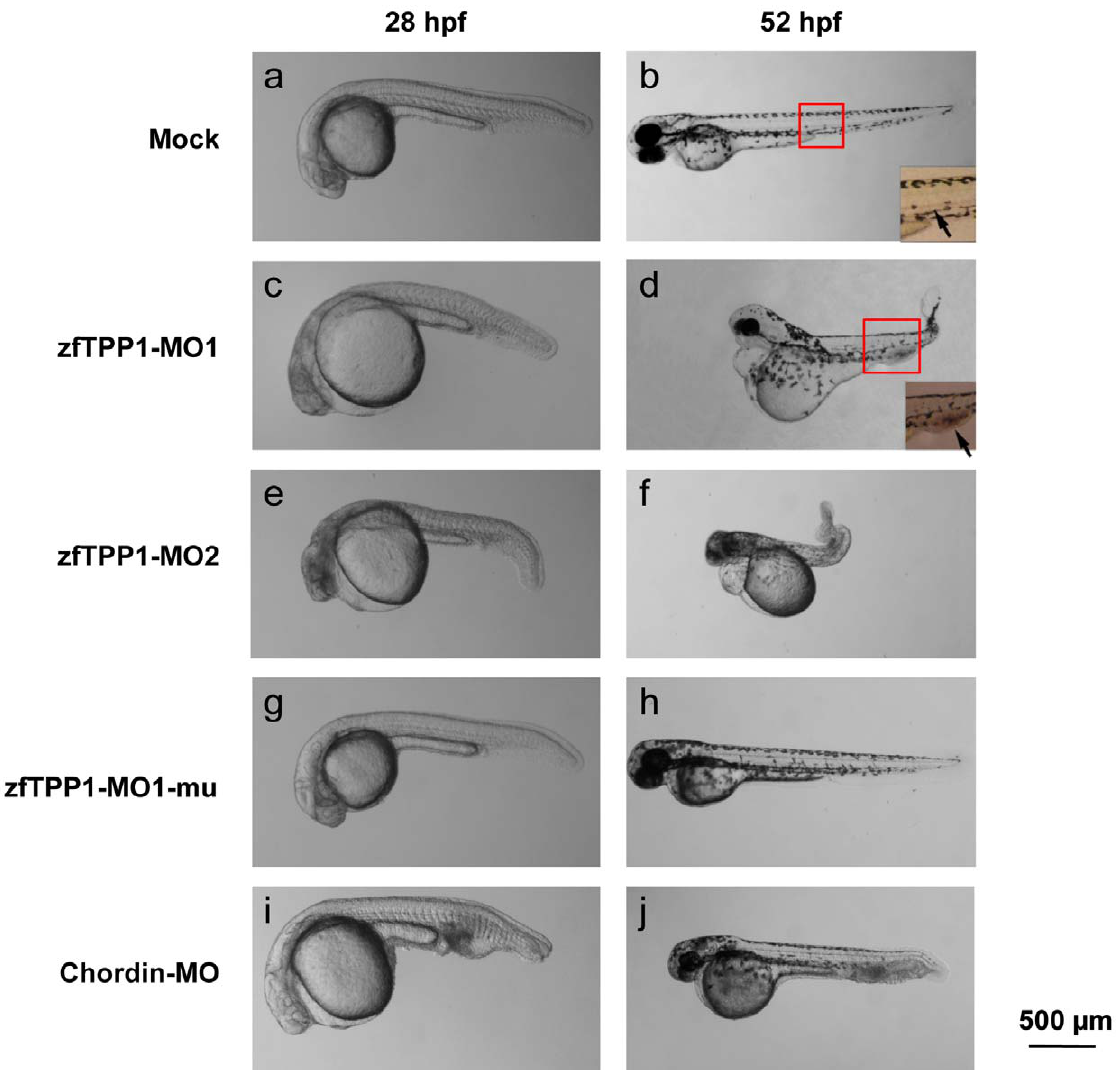
Figure 5. Expression of zfTPP1 morpholinos leads to defects in embryonic development. Mock injected zebrafish embryos (a, b) and those injected with zfTPP1 MO1 (6 ng) (c, d) and MO2 (3 ng) (e, f), zfTPP1 MO1 mutant (6 ng) (g, h), or Chordin MO (6 ng) (i, j), were observed under the microscope at 28 and 52 hour post fertilization (hpf). Magnified images of the trunk region of mock and MO1 injected embryos were also included. Arrows indicate blood in the embryos. Scale bar, 500 m m.